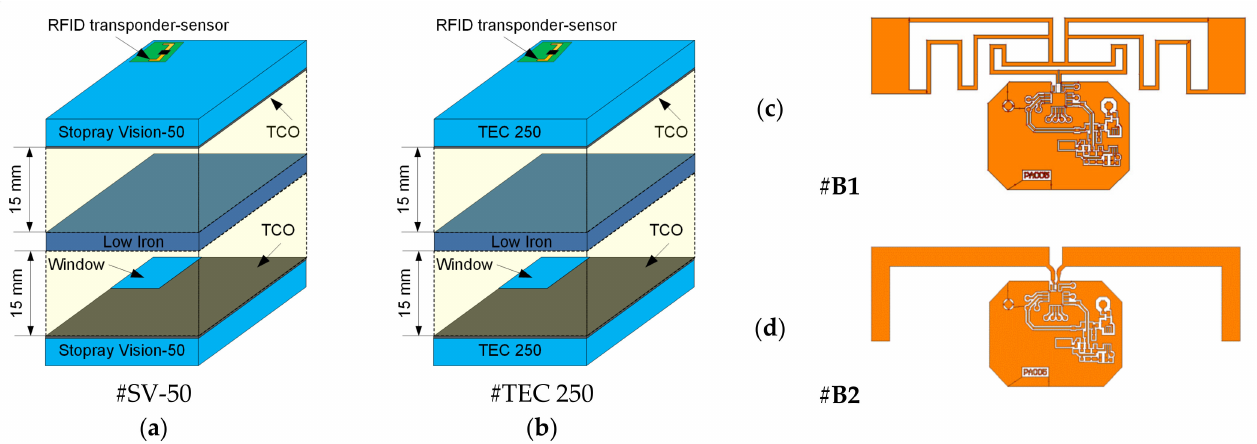
Figure 14. Model of RFID antenna for bidirectional communication: ( a ) Arrangement #SV-50 with Stopray Vision-50; ( b ) Arrangement #TEC 250 with NSG TEC 250 (Table 1); ( c ) Antenna design #B1; ( d ) Antenna design